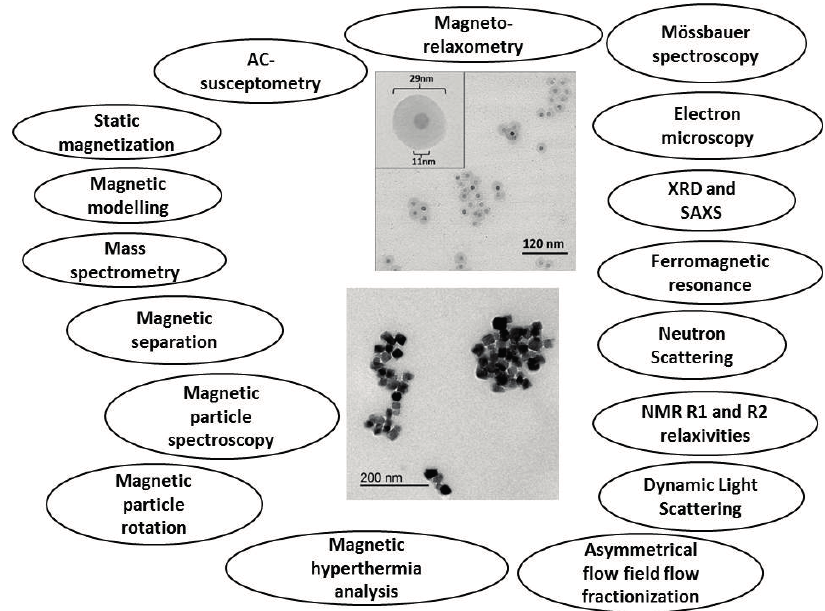
Figure 2. Analysis techniques used in the NanoMag project for the characterization and analysis of synthesized single- and multi-core nanoparticles shown in the TEM (transmission electron microscopy) images in the middle of the